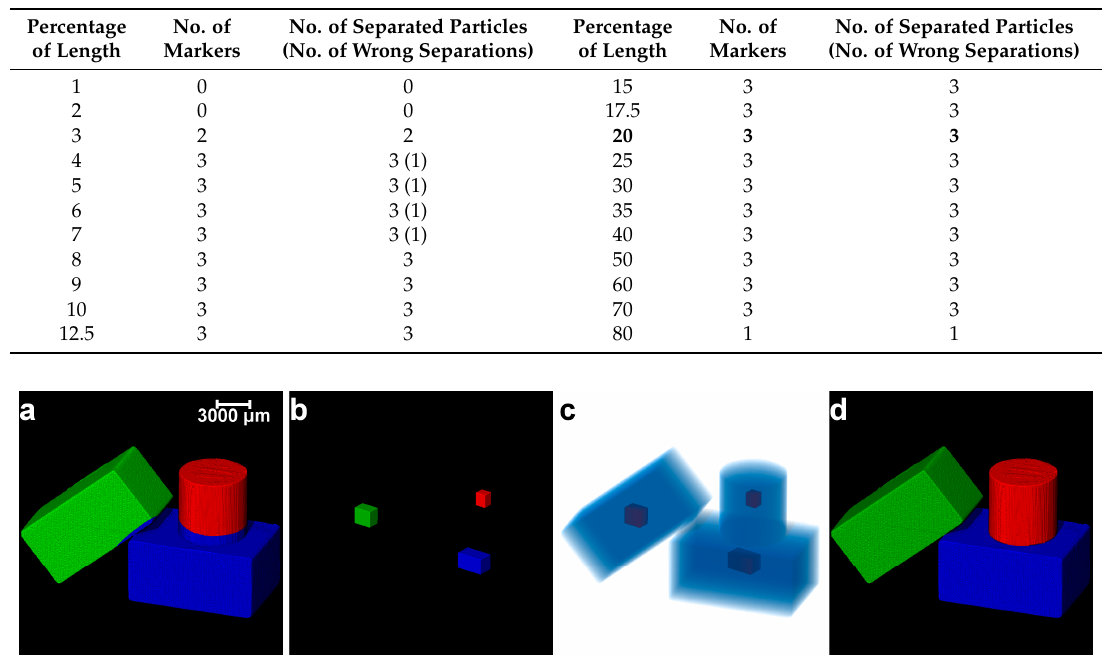
Table 1. Effects of the percentage of principal lengths on cuboid markers.